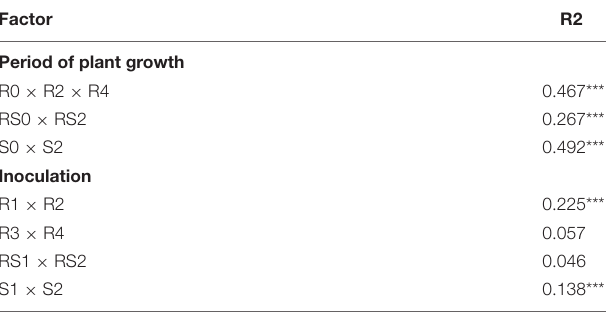
Weighted UniFrac beta-diversity distances were calculated for each subset of samples. Adonis tests were used to assess whether beta-diversity is related to sample groupings, 999 permutations, ***p <